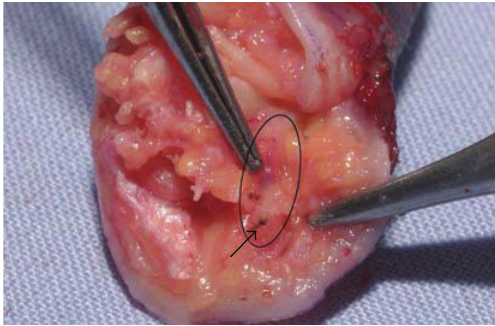
Figure 4: Intraoperative view of the amputated 5th finger showing a thrombosed digital artery (circle) with the visible thrombus at the dissected end